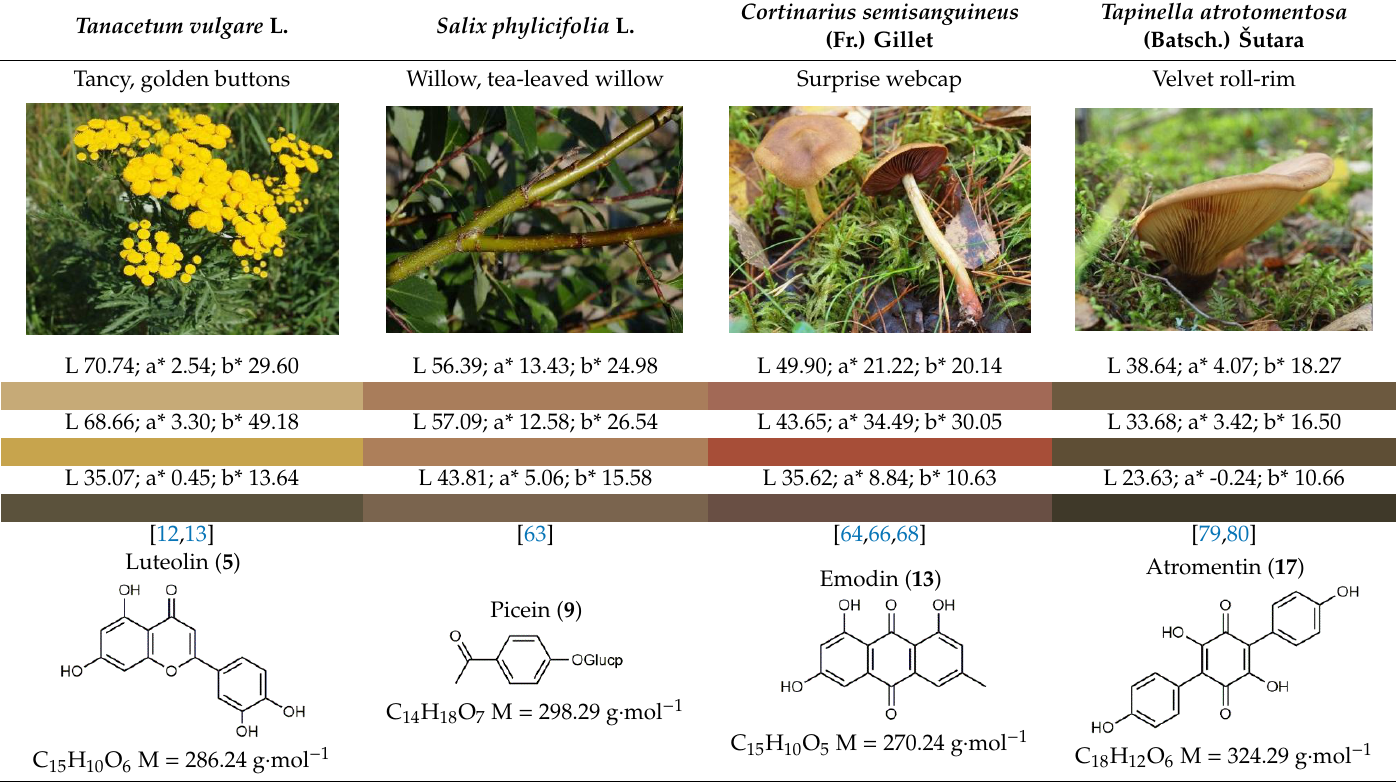
Table 2. Sources used in this research, their main colouring compounds as aglycones and dyeing results on wool as CIELab coordinates L, a*, b*. (Photos: Riikka Räisänen, except Salix phylicifolia by Jouko Rikkinen [74]).